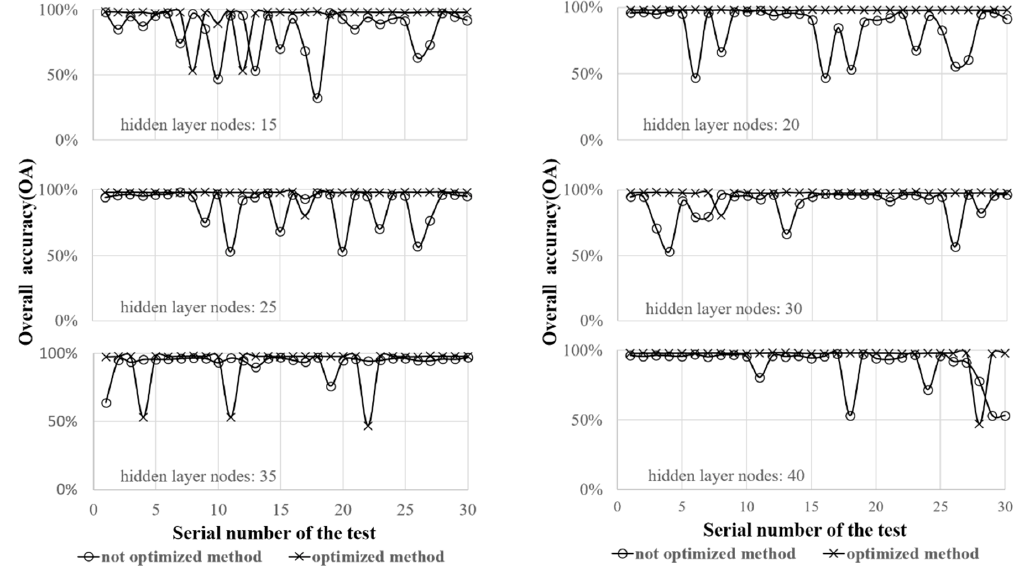
Figure 12. Classification overall accuracy of optimized and un-optimized WNN with different hidden layer nodes of Dataset 2.